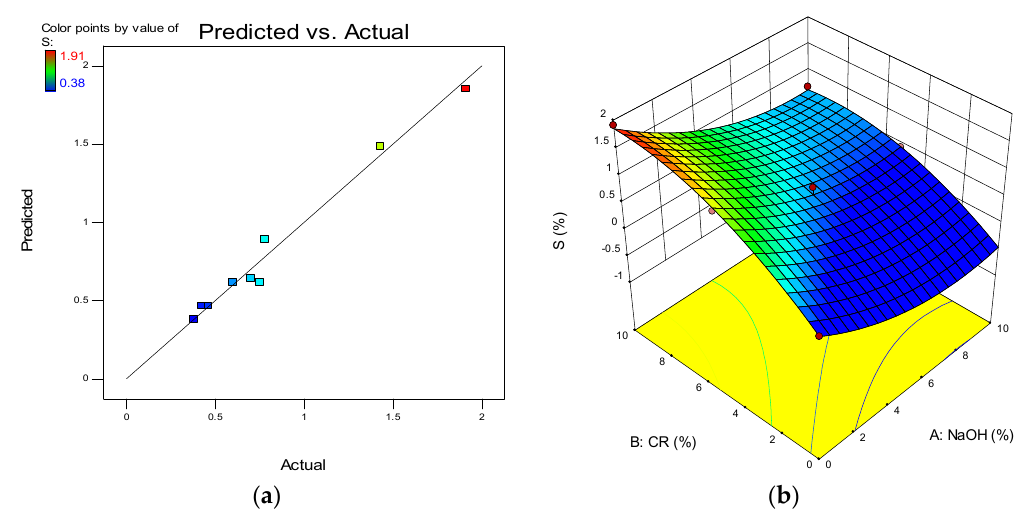
Figure 15. ( a ) Predicted vs. actual plot for S. ( b ) 3D response surface diagram for S.